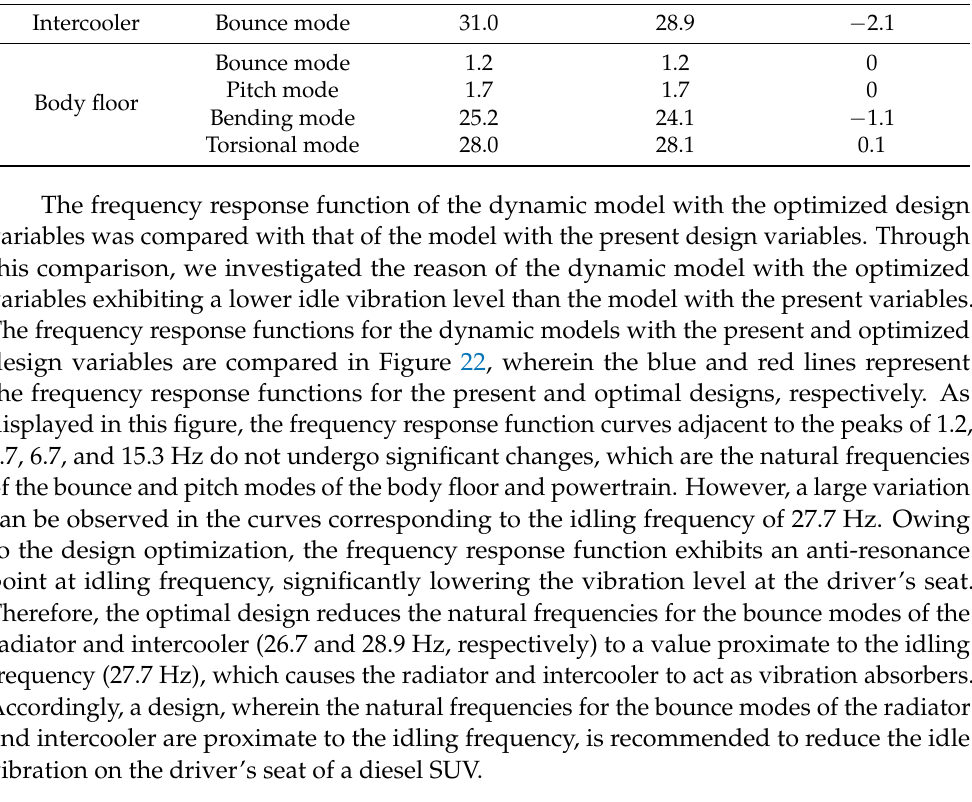
Table 5. Comparison of the natural frequencies for the present and optimal designs.